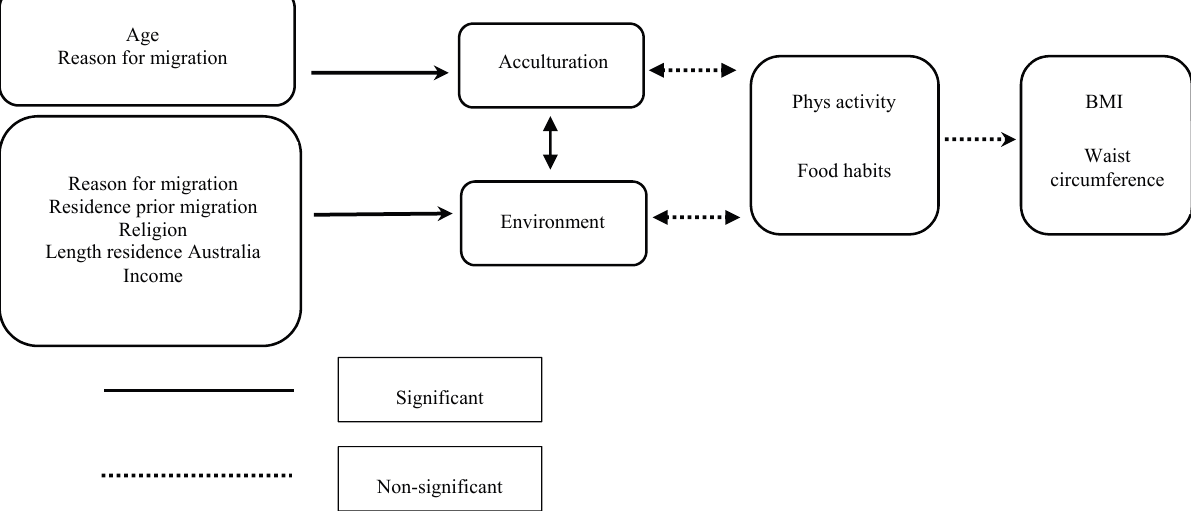
Figure 3. Path diagram showing the outcome of the path analysis. No significant interactions were found (see Tables 1 and 2 for